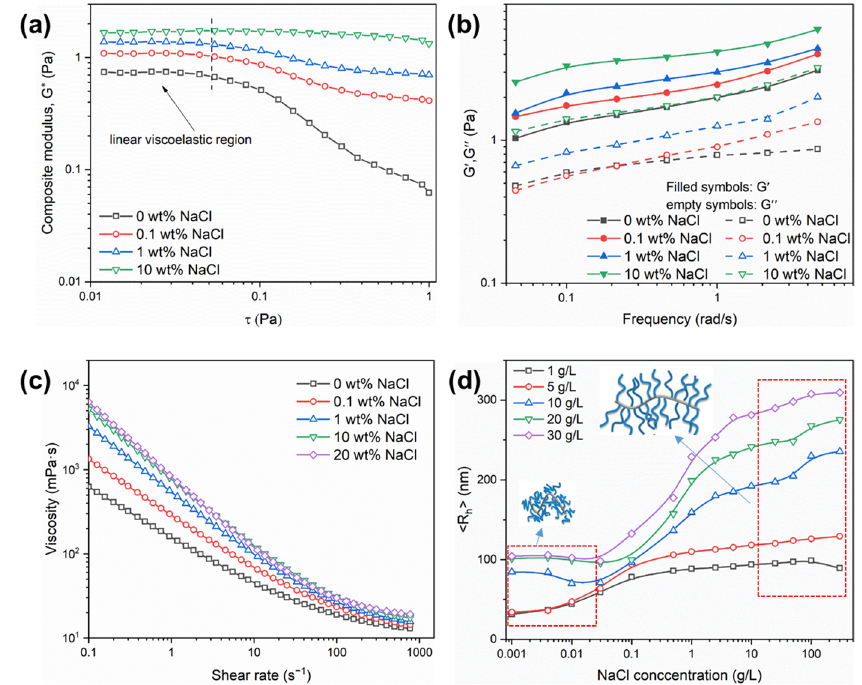
Figure 2. Viscoelastic behavior ( a ), the storage modulus (G ′ ), loss storage modulus (G ″ ) as a function of frequency ( b ), viscosity as a function of shear rate (logarithmic axes) ( c ) of 1.0 wt% PAND solution with different concentration of NaCl. ( d ) The mean hydrodynamic radius <R h > of PAND as a function of the NaCl concentration.